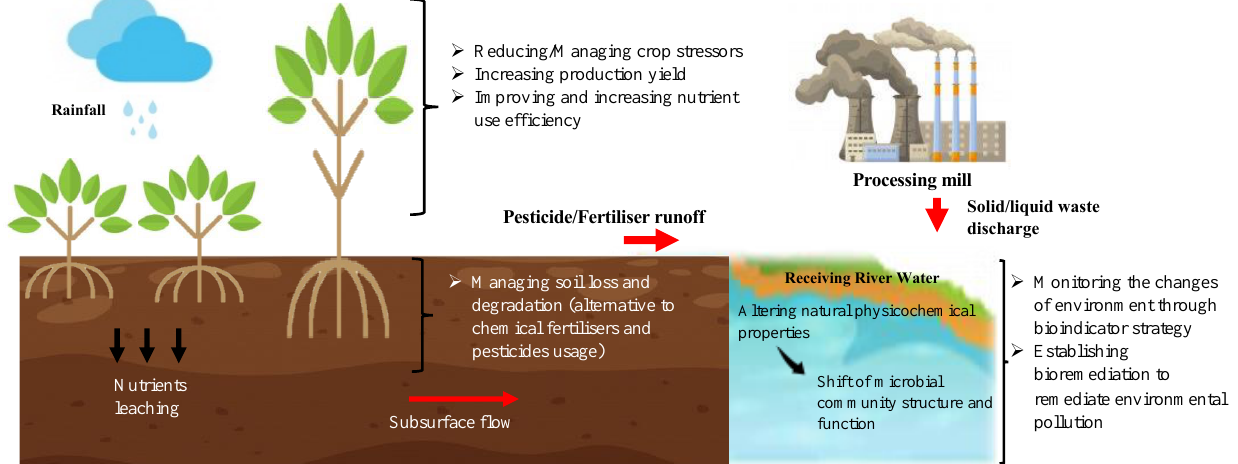
Figure 2. Schematic presentation of the major goals in promoting environmentally sustainable agriculture.